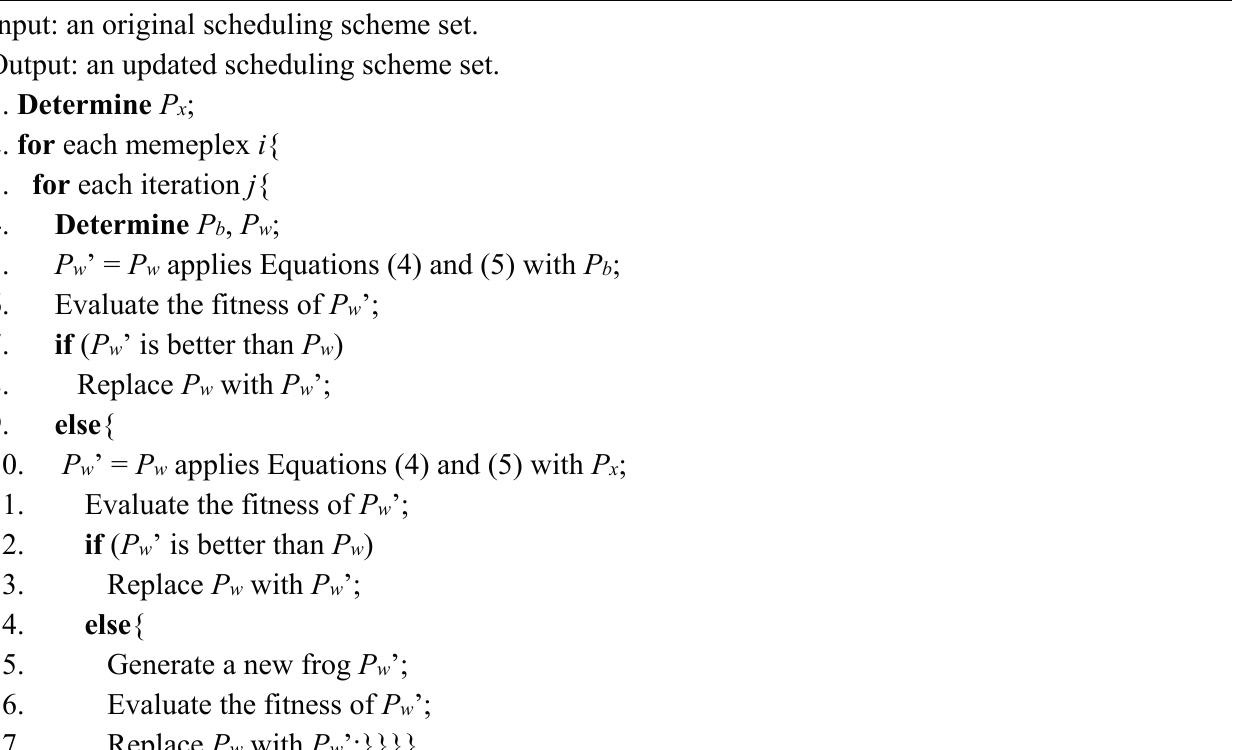
Algorithm 1. Sub-Population Information Transfer